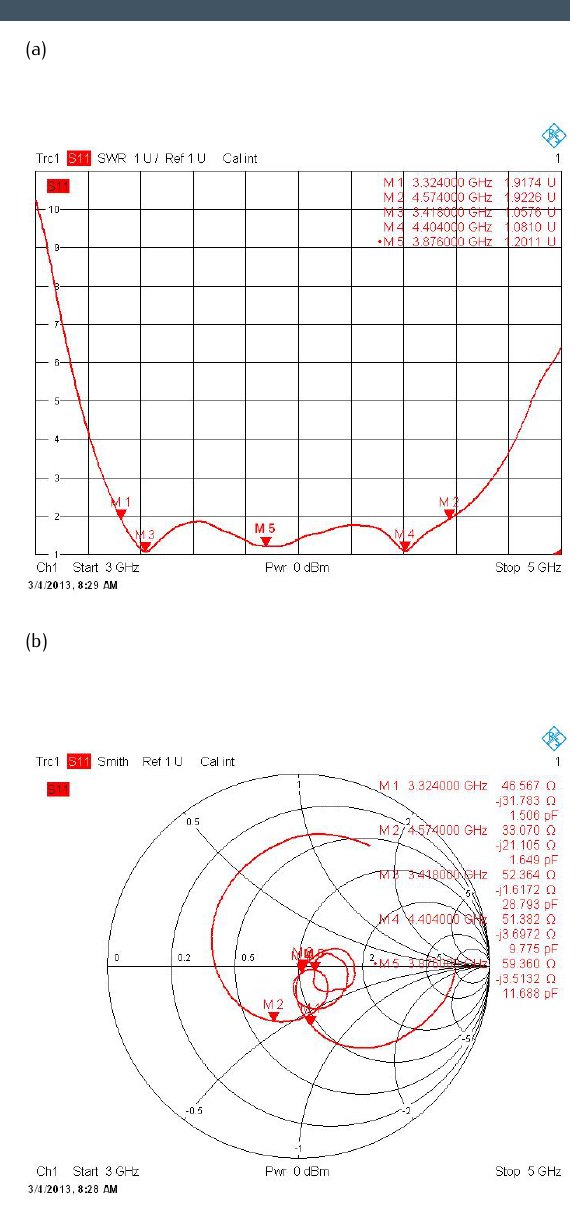
Figure 7. (a) Measured Voltage Standing Wave Ratio (VSWR) of stacked geometry with air gap h a = 1 . 59 mm and shorting pin; (b) Measured input impedance of stacked antenna geometry with air gap h a = 1 . 59 mm and shorting pin.